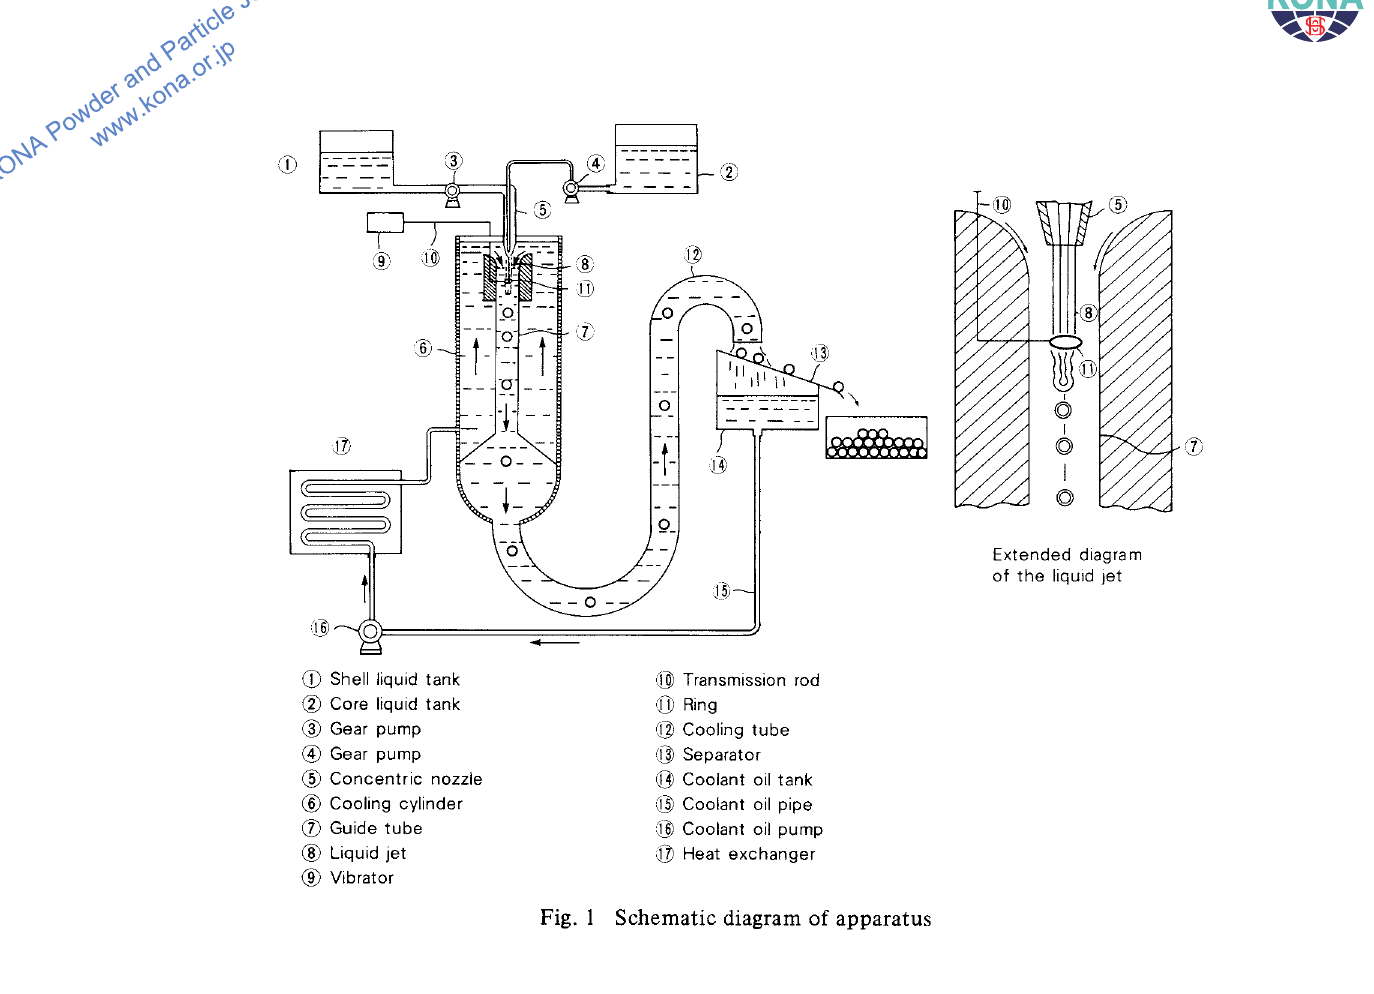
Fig. I Schematic diagram of apparatus